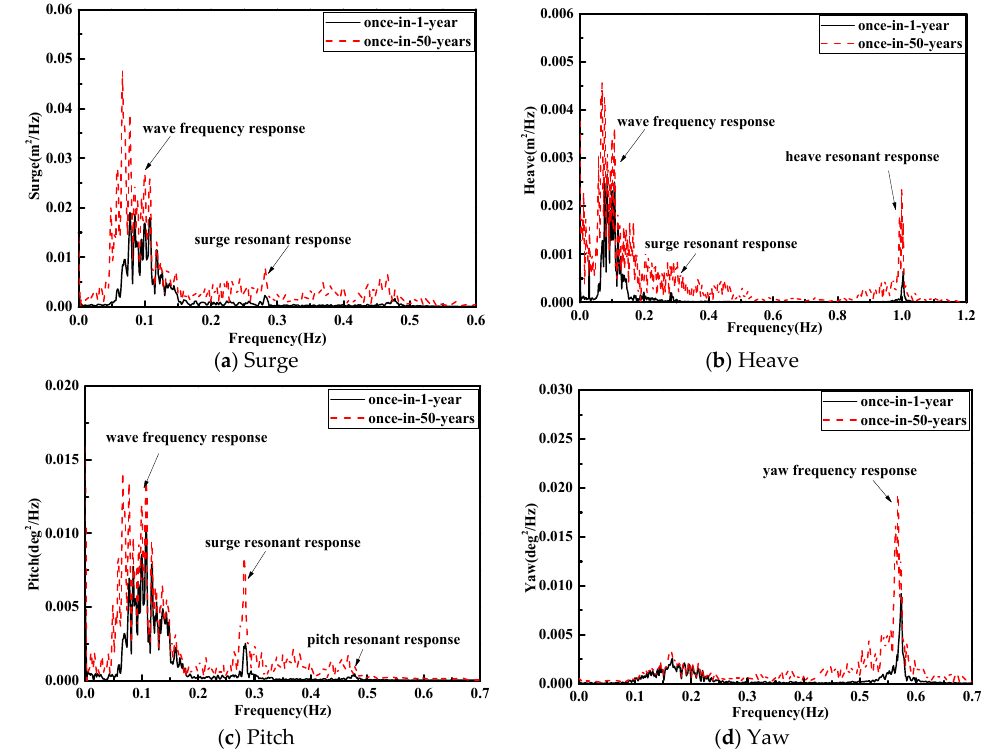
Figure 18. Power spectra of the platform motion under extreme sea-states.